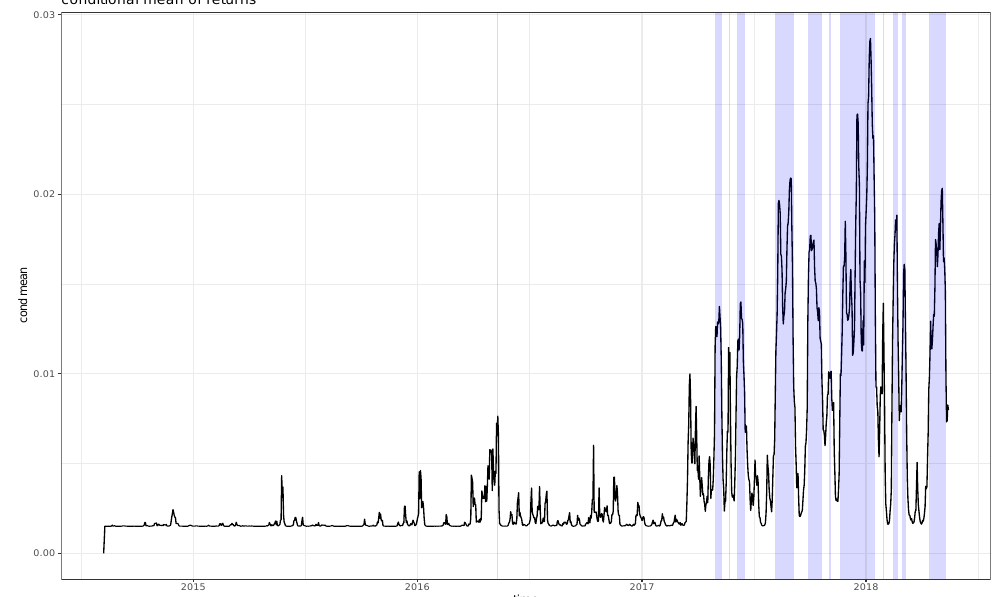
Figure 4. Estimated log volatility ( upper panel ) and conditional mean (lower panel ). The shaded areas Figure 3: Estimated log volatility (upper panel) and conditional mean (lower panel). The shaded correspond to the estimated bubble areas correspond to the estimated bubble periods.